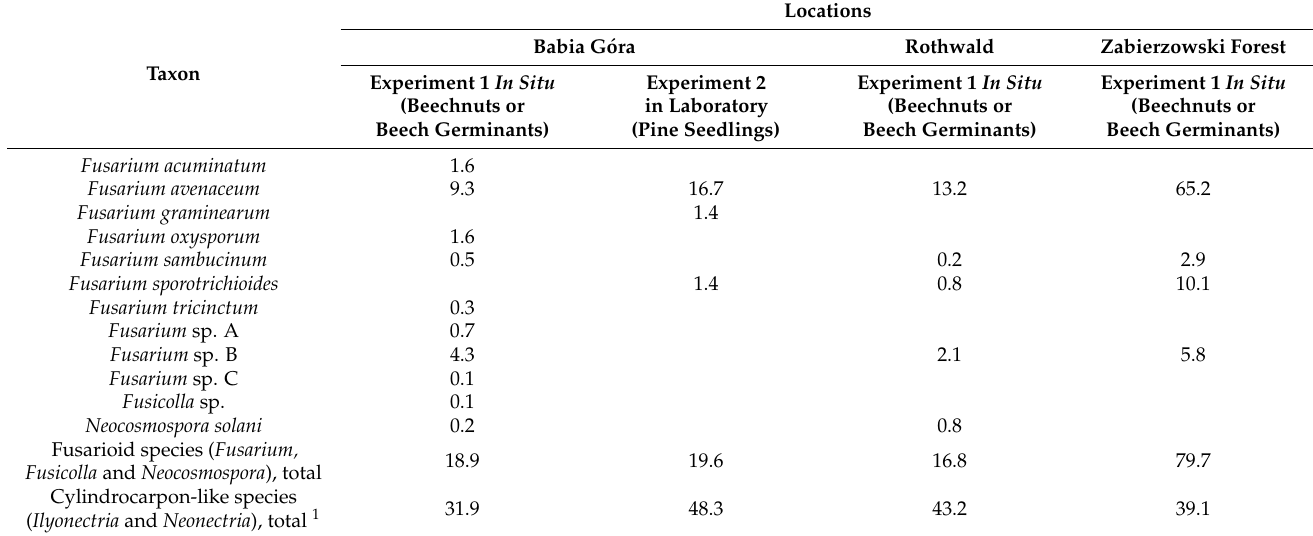
Table 3. Isolation frequency (%) of Fusarium and related genera from the beech litter collected at the three study sites. Locations Babia G ó ra Taxon